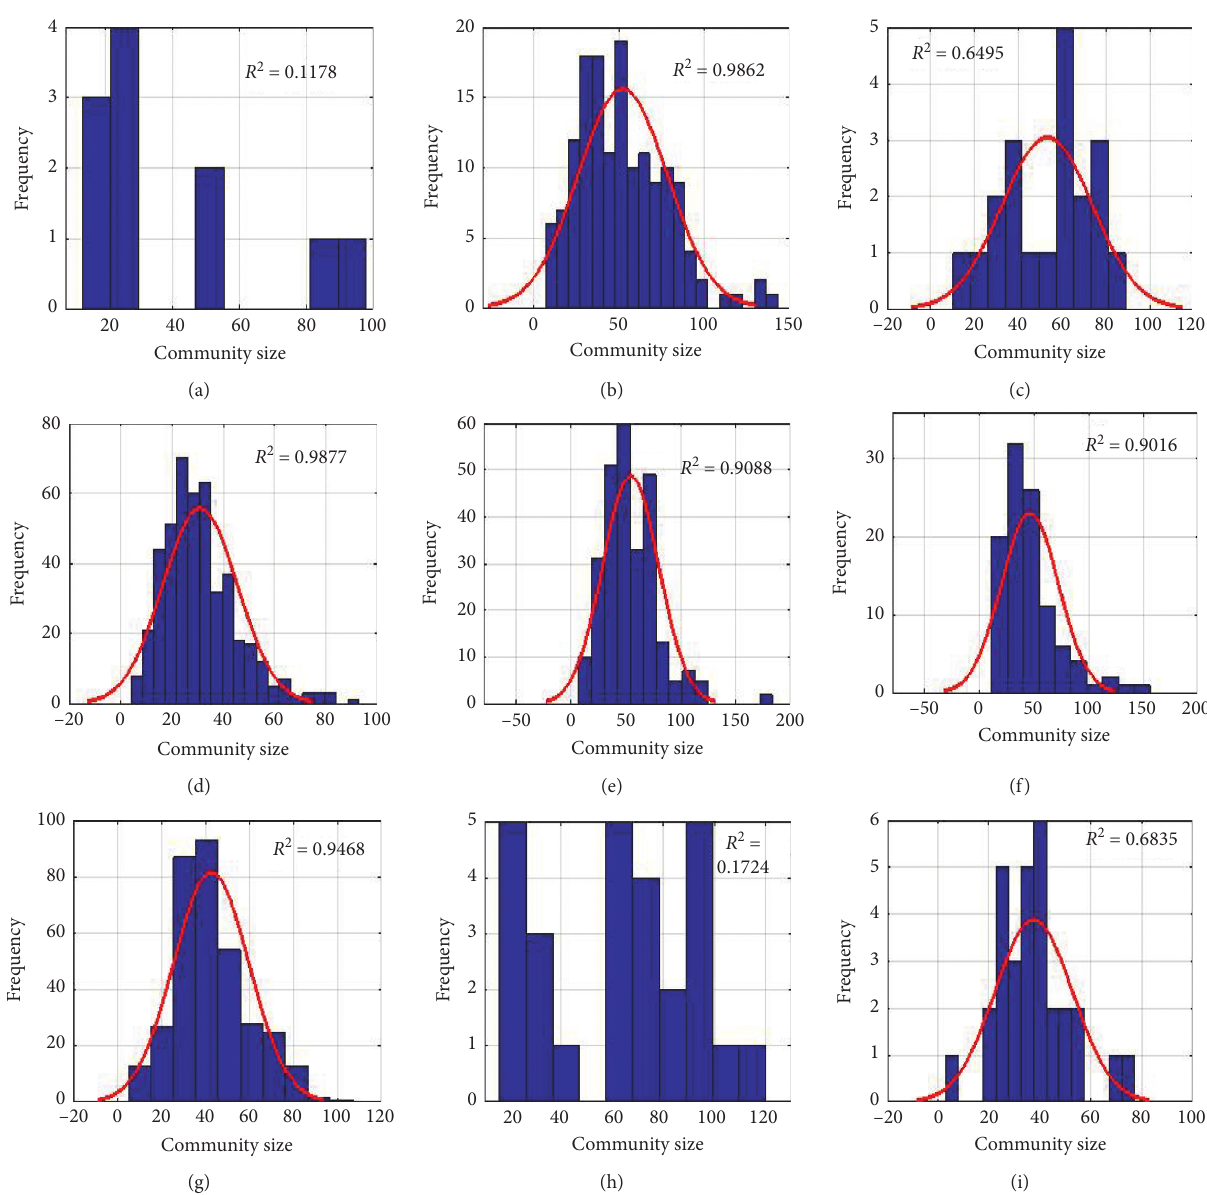
Figure 15: Histograms for nine URNs: (a) Anaheim; (b) Austin; (c) Barcelona; (d) Berlin; (e) Chicago; (f) Hessen; (g) Philadelphia; (h) Terrassa; (i)